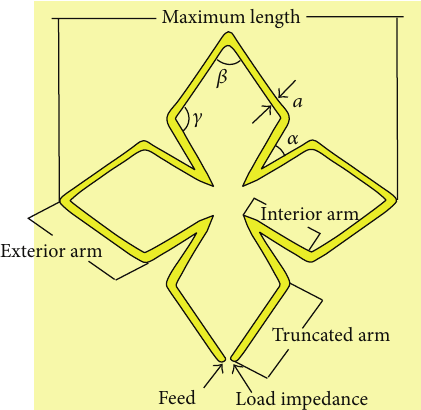
Figure 1: Cross rhombic antenna.